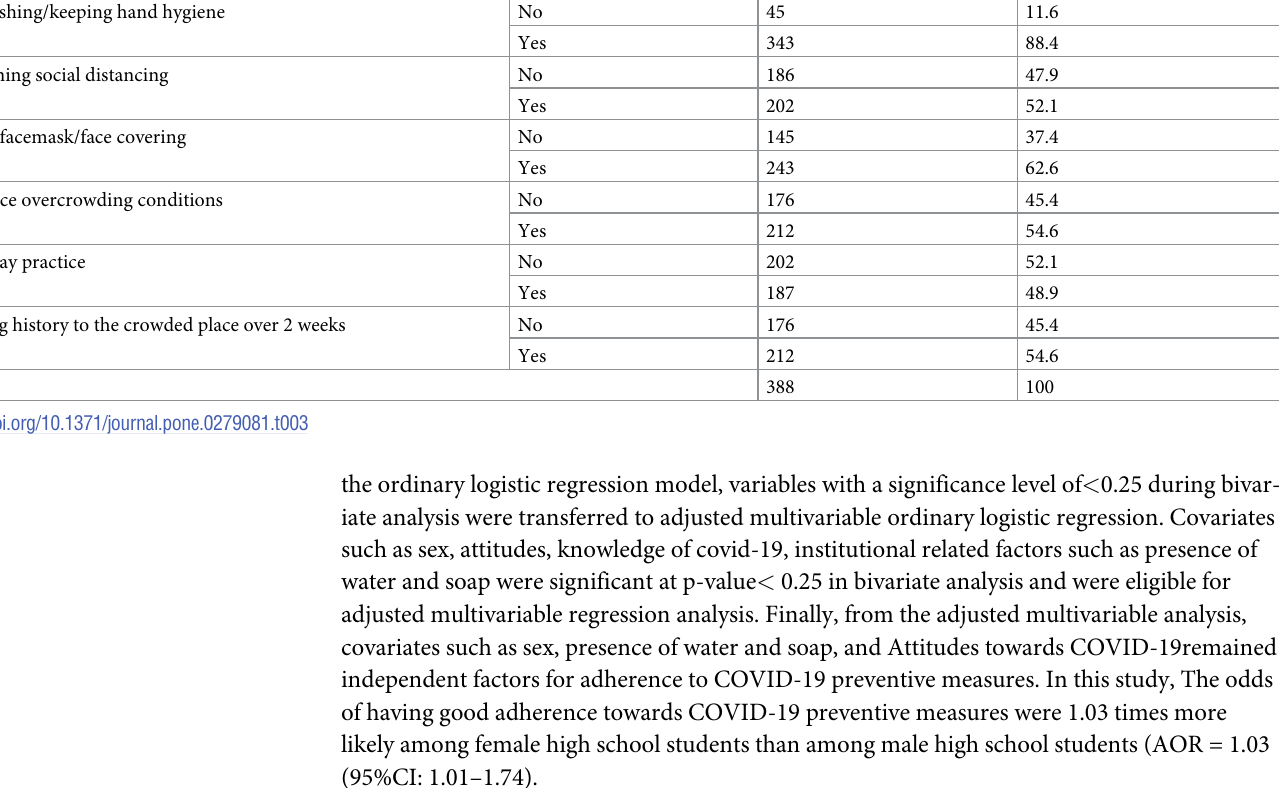
Table 3. The practice of COVID-19 preventive measures among students of Jimma high school, Jimma town south west Ethiopia, 2021 (N = 388). Characteristics